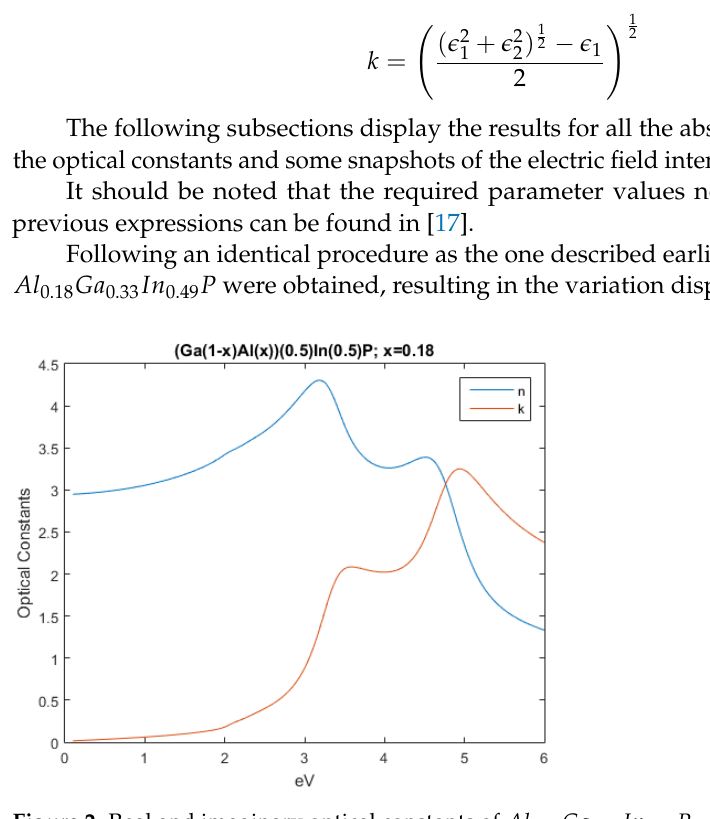
Figure 2. Real and imaginary optical constants of Al 0.18 Ga 0.33 In 0.49 P